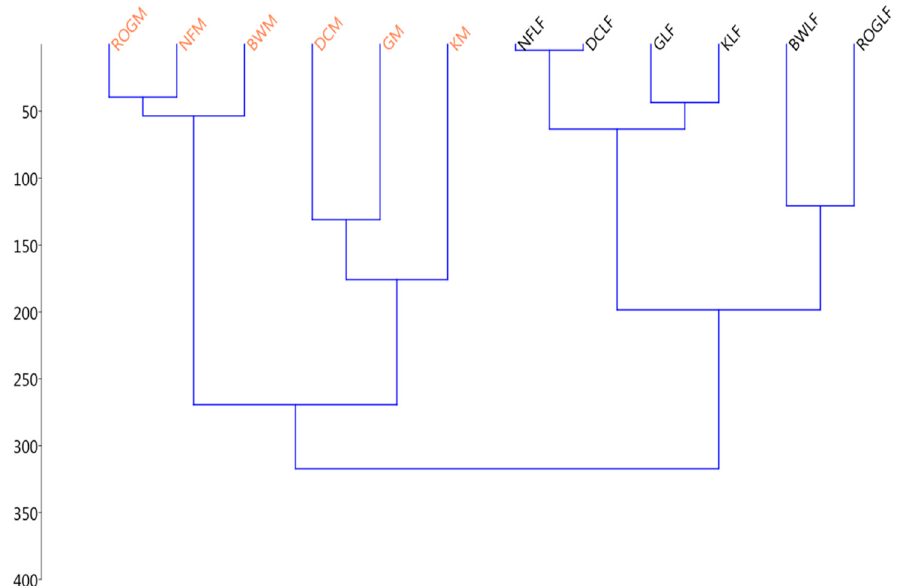
Figure 3. Clusters of the soil samples based on their thermodynamic properties. LF samples from the UK (ROGLF, BWLF, and KLF) and Ireland (DCLF, GLF, and KLF) form a cluster separated from two clusters of mineral samples from the UK (ROGM, BWM, and NFM) and Ireland (DCM, GM, and KM).